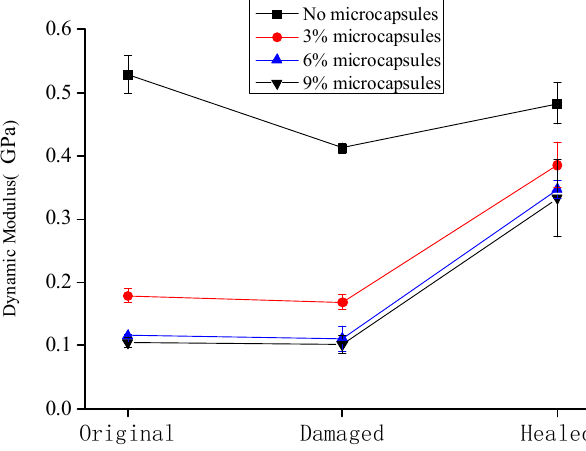
Figure 7. Variation in the dynamic modulus of the specimens.